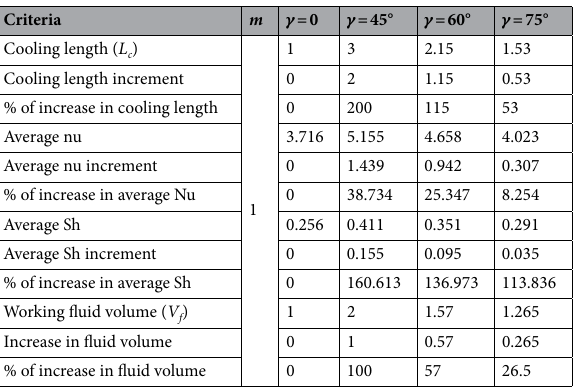
Table 8. Overall assessment with the increasing cooling length ( L c ) by γ when Le = Pe = 1, Da = 10 –3 , Gr = 10 4 , Ha = 30, m = 1, δ =